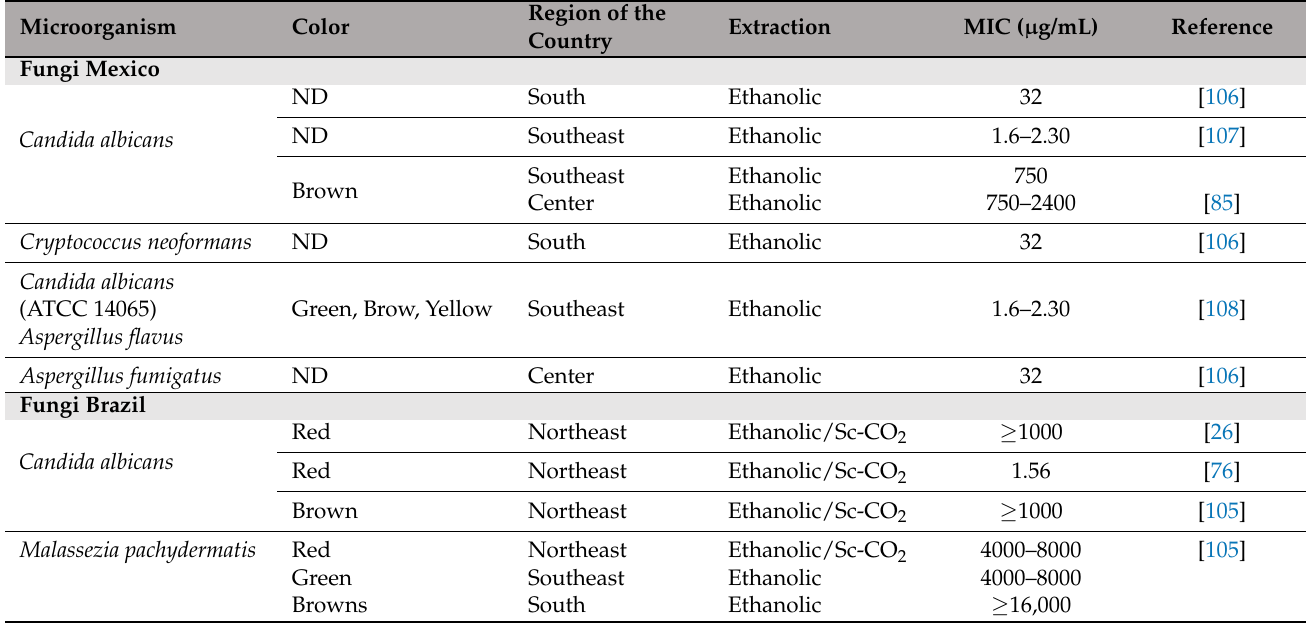
Table 2. Antifungal properties of propolis of different regions of Brazil and